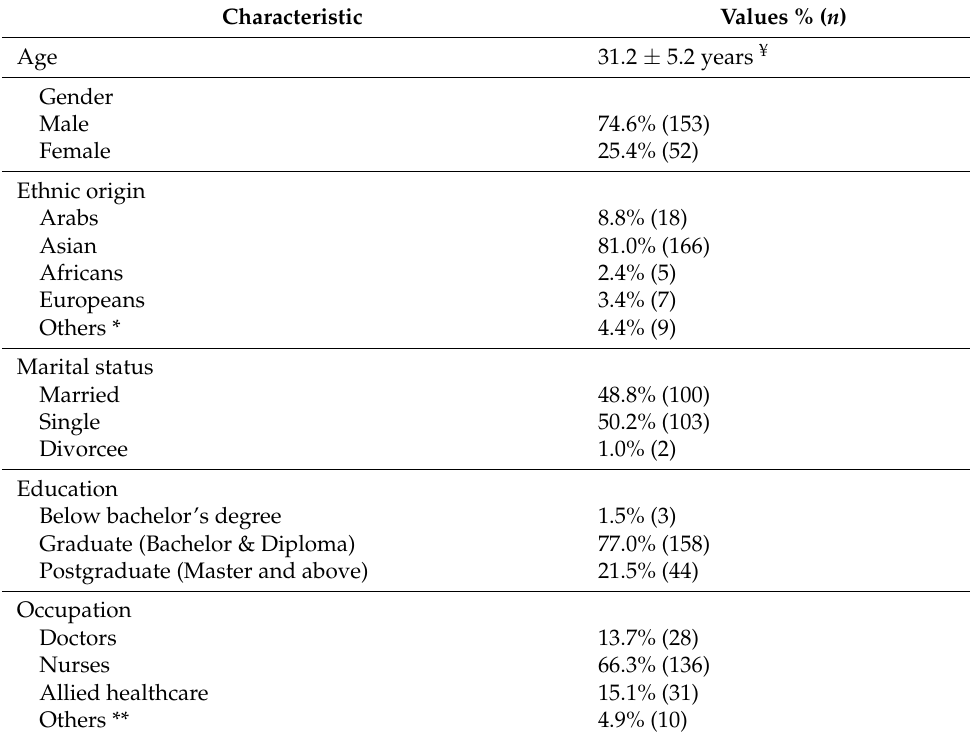
Table 2. Characteristics of the MetS-free participants ( n = 205) at baseline within 3 months of arrival to Qatar in 2017.